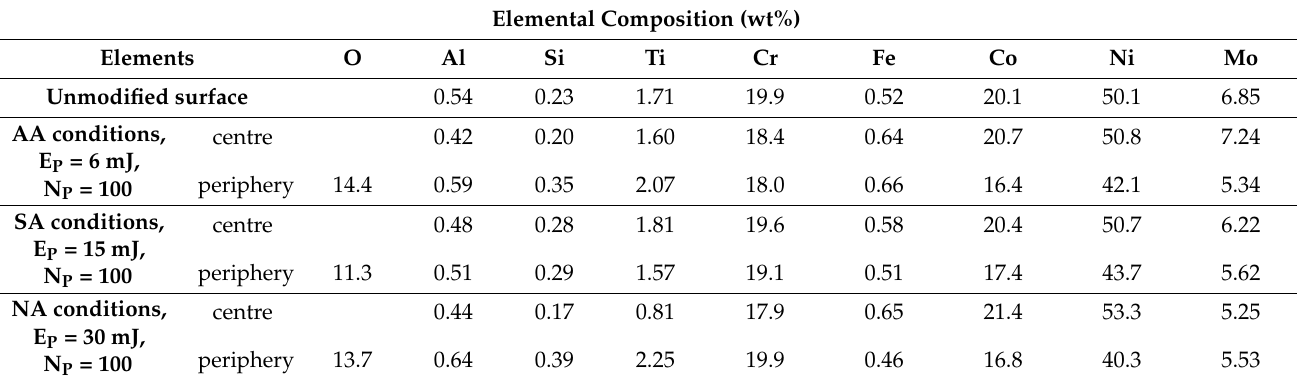
Figure 5. LIPSS structures obtained in standard atmospheric conditions and nitrogen-rich atmosphere after the irradiation of Nimonic 263 superalloy surface by picosecond Nd:YAG laser. Table 3. EDS analysis of Nimonic 263 superalloy surface before and after the picosecond laser irradiation under different experimental